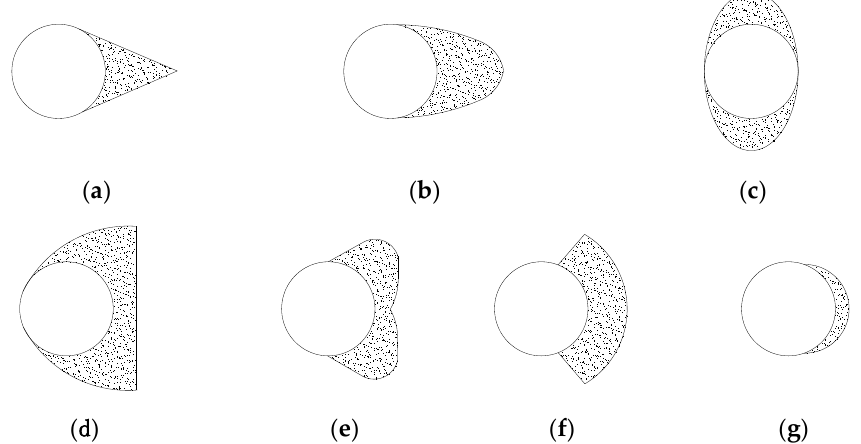
Figure 1. Schematic diagram of ice shapes: ( a ) trilateral shape, ( b ) crescent shape, ( c ) ellipse shape, ( d ) D shape, ( e ) D shape, ( f ) sector shape, ( g ) crescent shape.